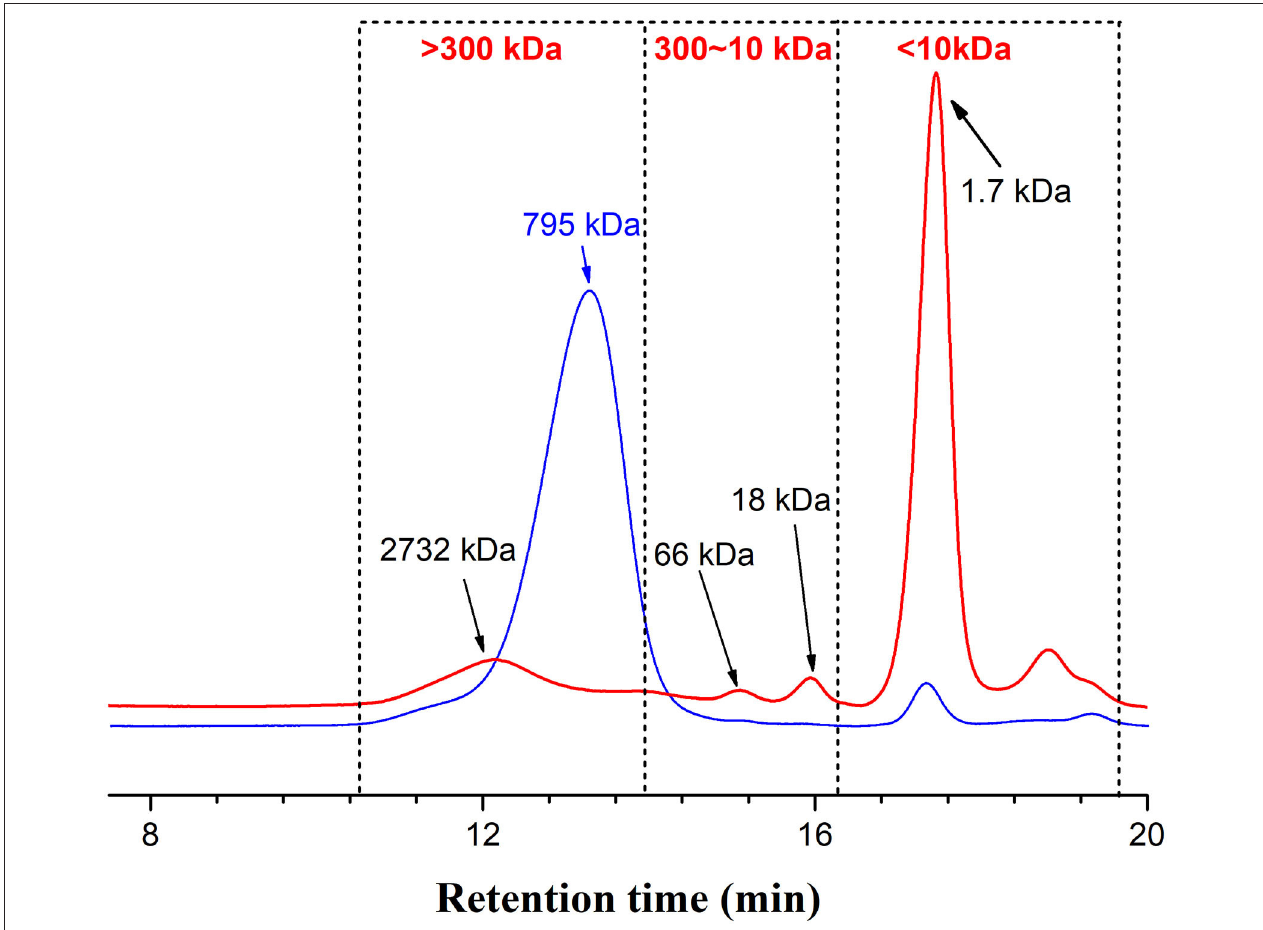
FIGURE 1 | Profiles of Fstd (blue line) and WH (red line), monitored by high-performance gel permeation chromatography (HPGPC), coupled with a refractive index detector (RID). Fstd, fucoidan standard; WH, fucoidan extracted from Weihai seaweed Undaria pinnatifida .